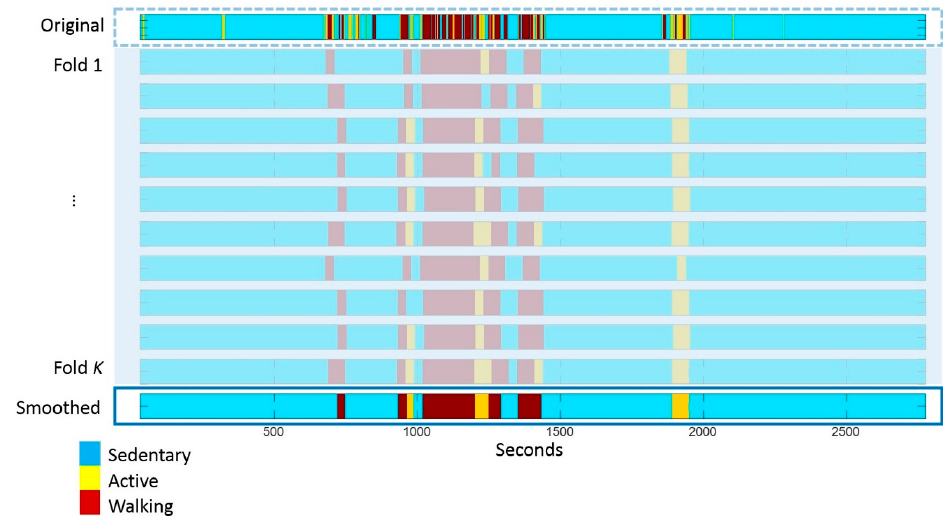
Figure 1. Smoothing activity classification output to aggregate activity bouts in a measurement time series of 45 min. The top bar shows the original PA sequence and the bottom bar shows the smoothed sequence.